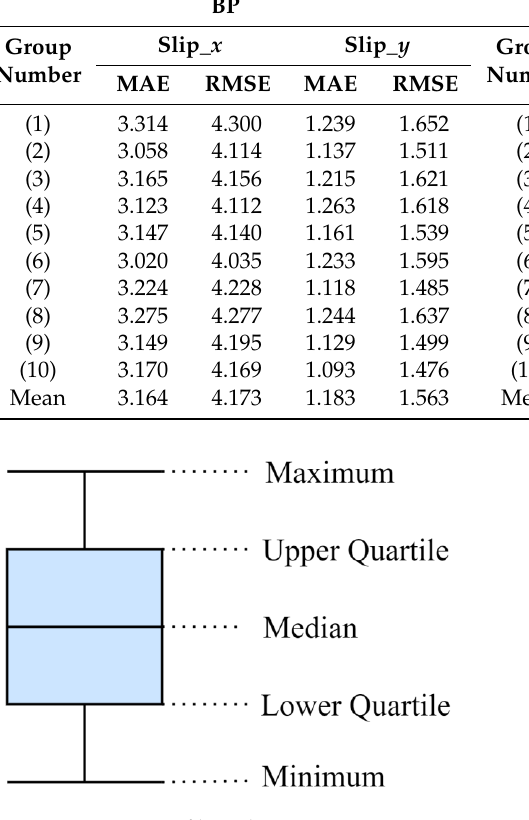
Figure 8. Structure of